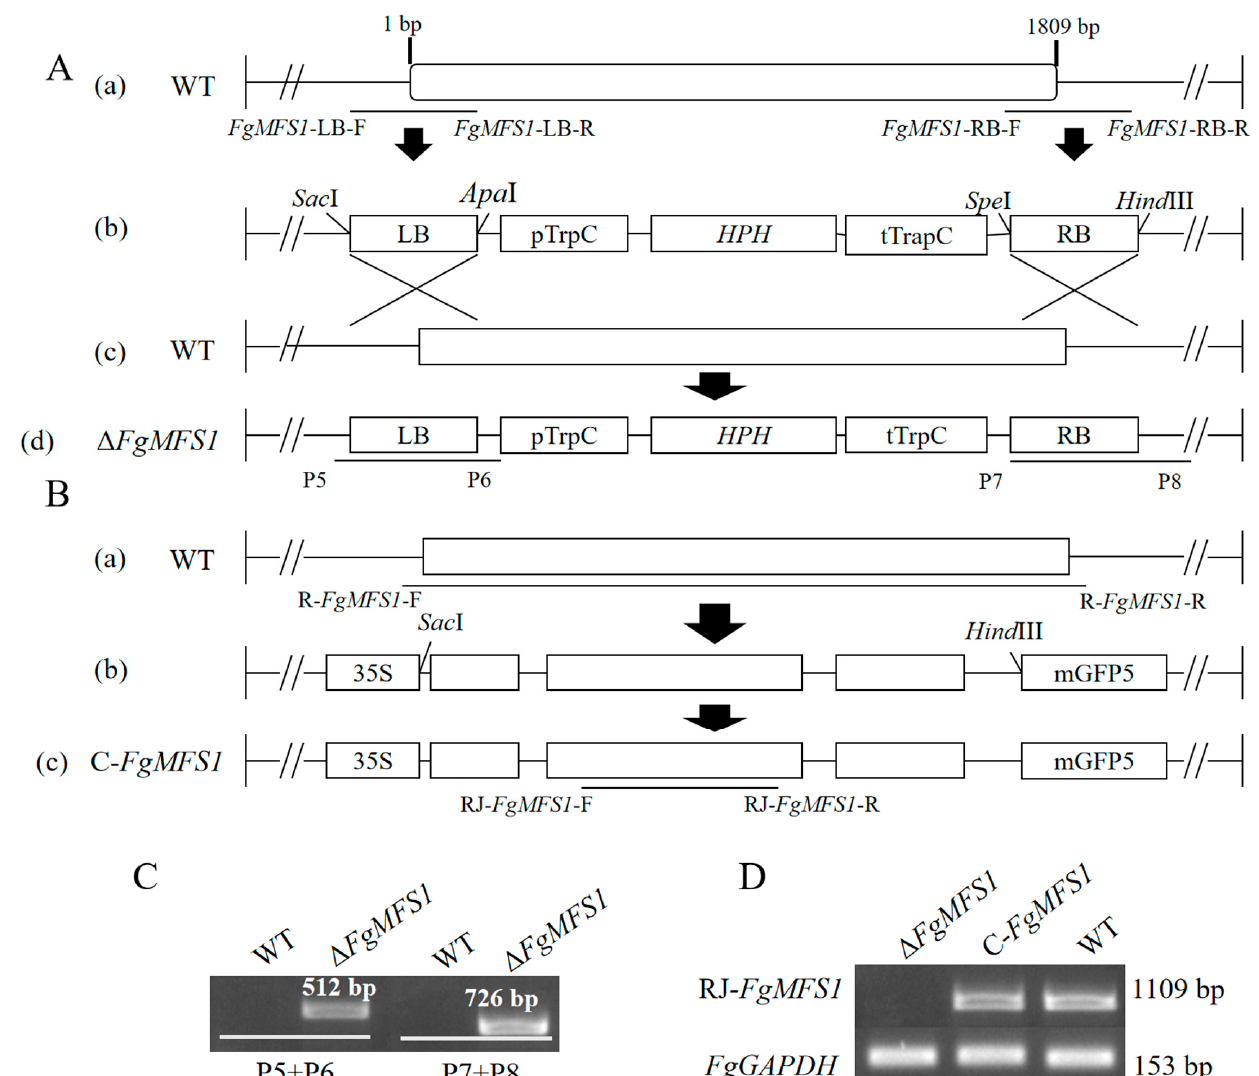
Figure 4. Preparation of the Δ FgMFS1 and C-FgMFS1 mutants. ( A ) Disruption of FgMFS1 . The left border (LB) and right border (RB) of FgMFS1 for homologous recombination were cloned, by using the primer pairs FgMFS1 -LB-F + FgMFS1 -LB-R and FgMFS1 -RB-F + FgMFS1 -RB-R, respectively (a), and ligated into the plasmid (b). The ∆ FgMFS1 mutants (d) were generated from a recombination that occurred between the plasmid (b) and the homologous sequence of FgMFS1 in the wild-type (WT) F. graminearum strain (c). ( B ) Complementation of FgMFS1 . The full open reading frame of FgMFS1 was cloned from the WT strain by using primer pair R- FgMFS1 -F + R- FgMFS1 -R (a) and ligated into the complementation plasmid (b). The T-DNA region of the complementation plasmid was randomly inserted into the genome of ∆ FgMFS1 to generate the C-FgMFS1 mutants (c). Apa I, Sac I, Hind III, and Spe I indicate the cutting sites of corresponding restriction enzymes used. ( C ) Verification of the ∆ FgMFS1 mutants by PCR, with primer pairs P5 + P6 and P7 + P8, which are located at the upstream and downstream of the inserted T-DNA region in ∆ FgMFS1 , respectively. ( D ) Verification of the expression of FgMFS1 in the ∆ FgMFS1 and C-FgMFS1 mutants by reverse transcription (RT)-PCR, with RJ- FgMFS1 -F + RJ- FgMFS1 -R. The FgGAPDH (Fg- GAPDH -F + Fg- GAPDH -R) gene was used as the reference. The black lines between primers show the amplified sequences. The PCR amplification products were validated by sequencing in Qingke biotech (Chengdu, China). The sequences for primers can be found in Table